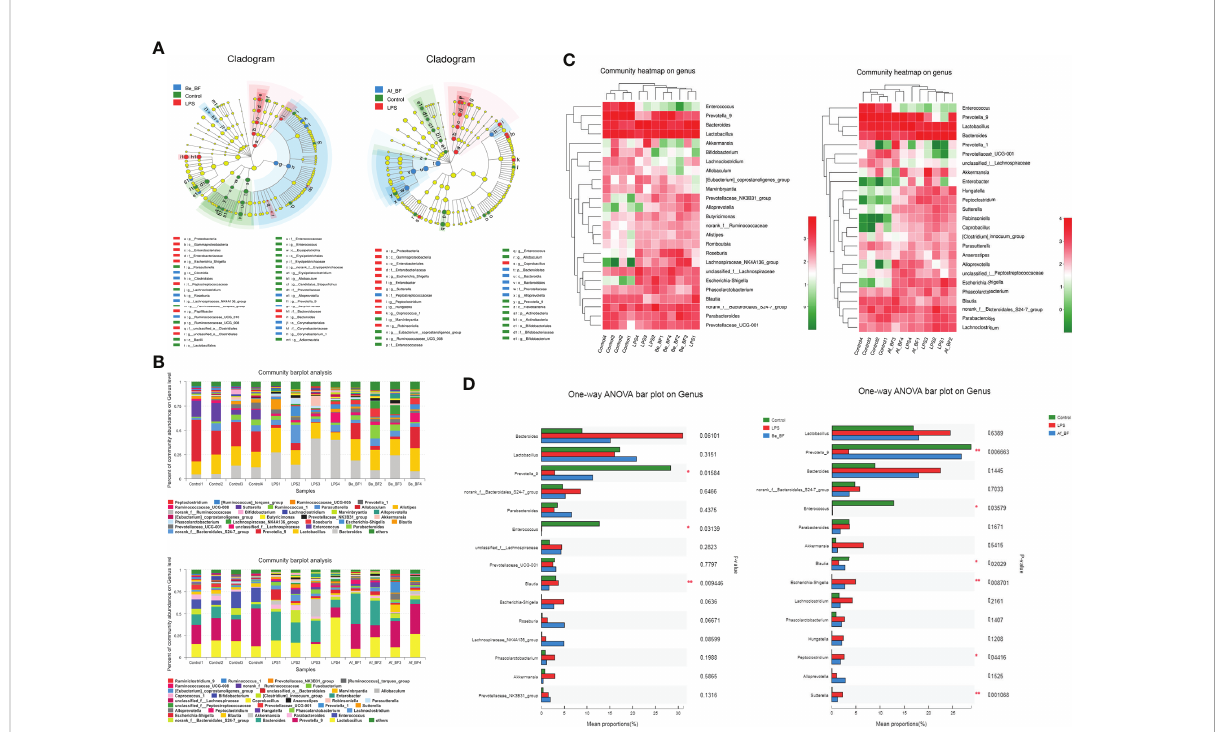
FIGURE 9 Comparison of gut microbiome composition between LPS-treated samples and B . fragilis treatment groups. (A) Linear discriminant analysis (LDA) coupled with effect size measurements identi fi es the most differentially abundant taxons among the control, B. fragilis treatment groups (A-1 for Be_BF group; A-2 for Af_BF group), and LPS-treated group. Enriched Taxa are shown with different colors (Control group for blue, B . fragilis treatment groups for green, and LPS-treated group for red). Only taxa meeting an LDA signi fi cant threshold of >3.5 are shown. (B) Community abundance ratio on the genus (B-1 for Be_BF group; B-2 for Af_BF group). (C) Community heatmap on genus with top 25 differential abundance (C-1 for Be_BF group; C-2 for Af_BF group). (D) One-way ANOVA bar plot on genus with top 15 differential abundance (D-1 for Be_BF group; D-2 for Af_BF group). * p < 0.05; ** p <